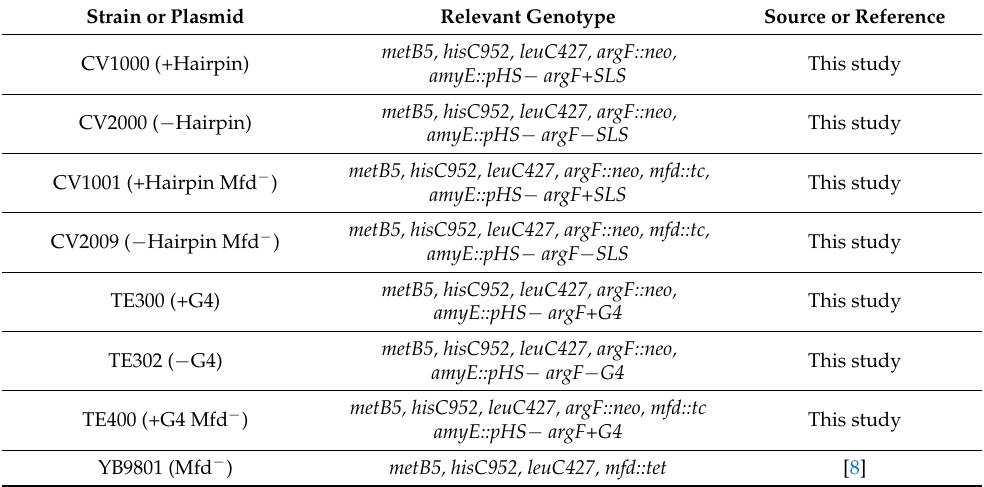
Table 1. Strains and plasmids used in this